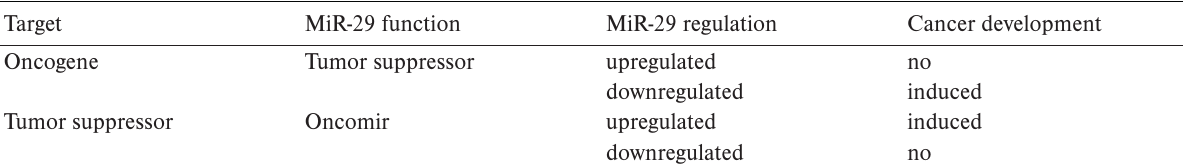
Table 1. MiR-29 involvement in cancer.